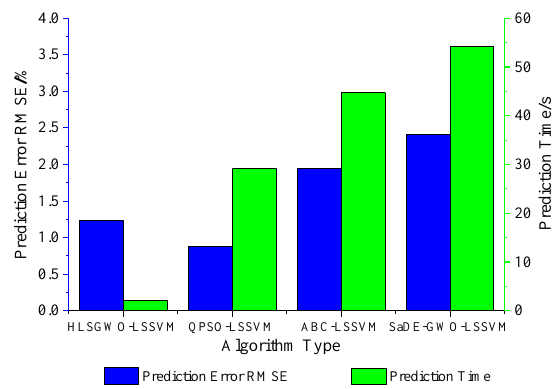
Figure 6. The chart of error–time comparison.